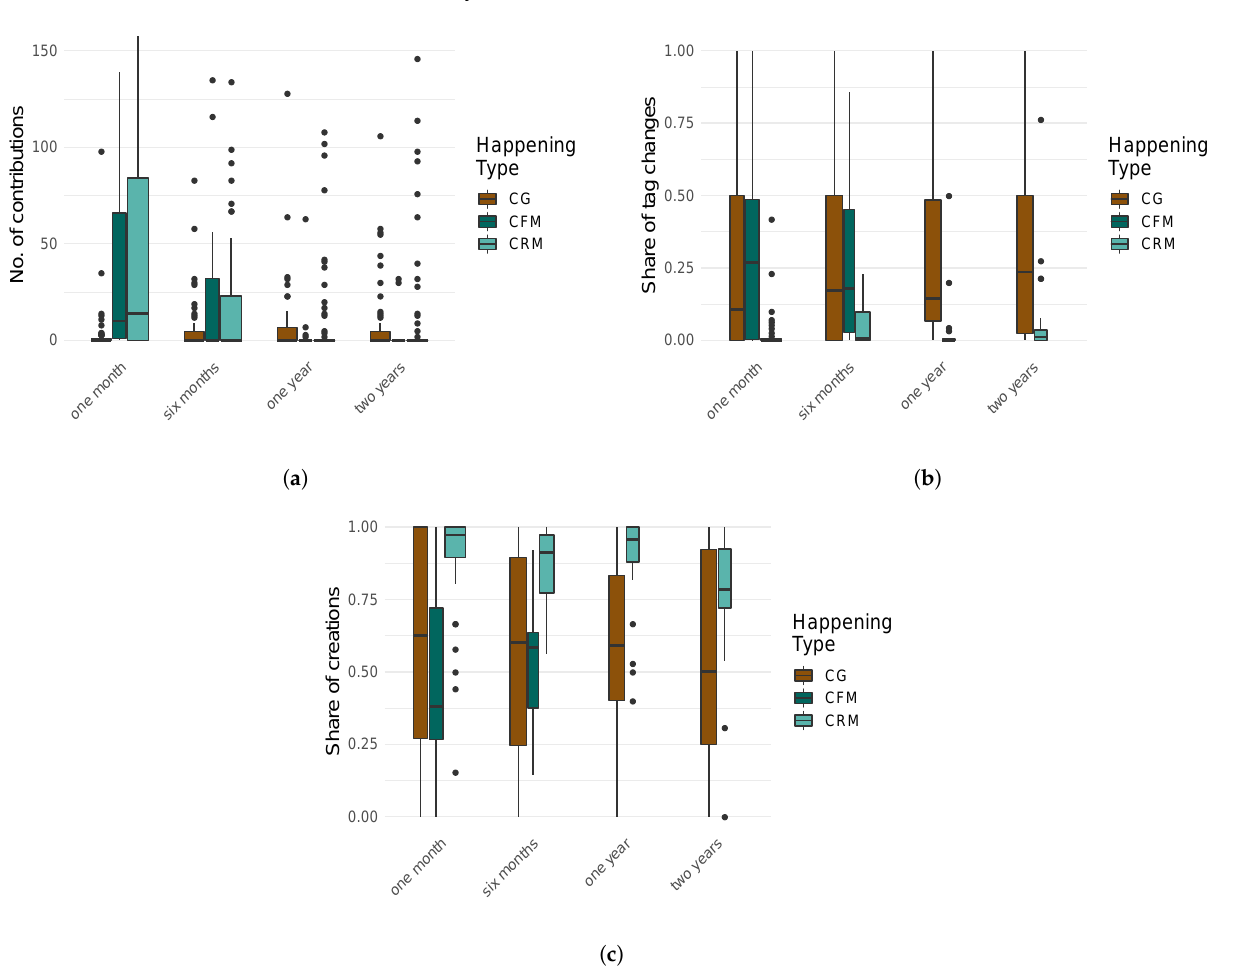
Figure 7. Three example graphs showing the effects of happenings on newcomers: ( a ) contribution quantity, ( b ) tag changes share and ( c ) creations share. The quantity was higher in median for the one month interval but faded later. The share of creations and the share of tag changes seemed to be preserved from the respective happening. The width of the boxes is relative to the number of mappers in the respective class (see Table 3). Graph ( a ) was cropped at 150 contributions, but the total maximum was 21,582. In ( b ) and ( c ) CFM users could not be analysed for the one and two years time period due to the sample size falling below